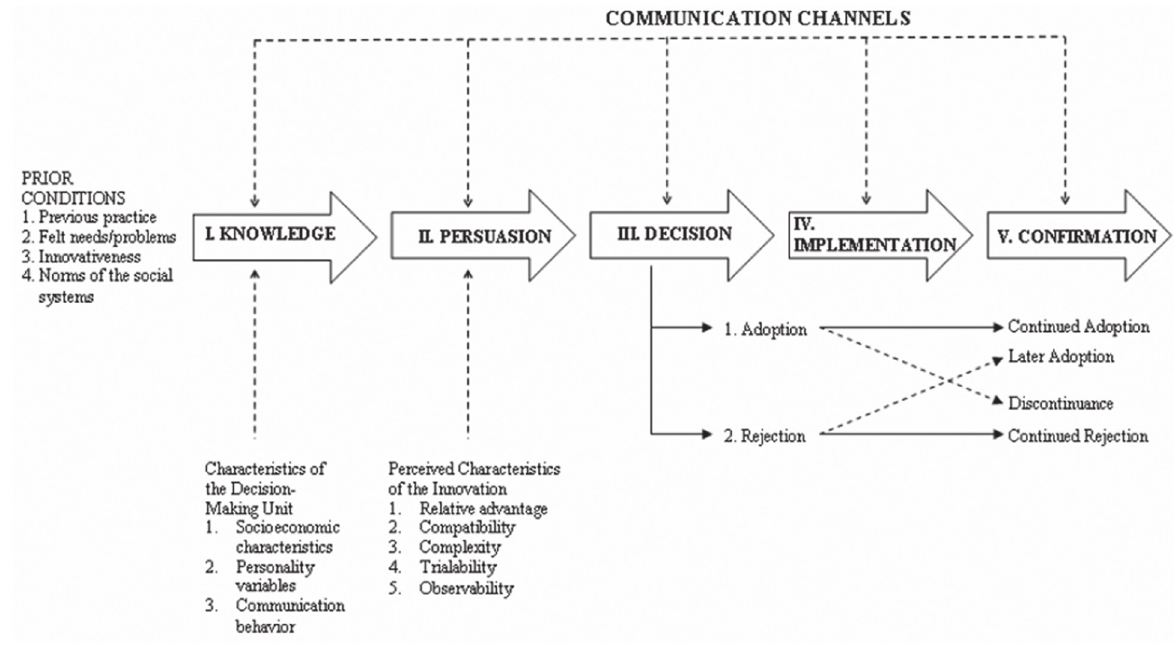
Figure 1 - Roger (1995:163), "Innovation - Decision